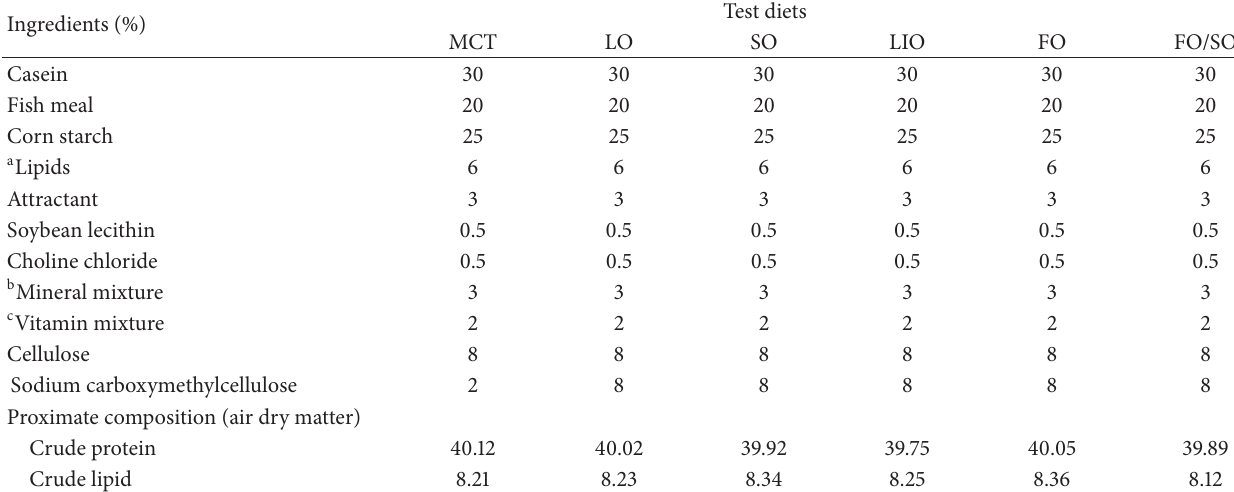
Table 1: Ingredient composition and nutrient content of the test diets